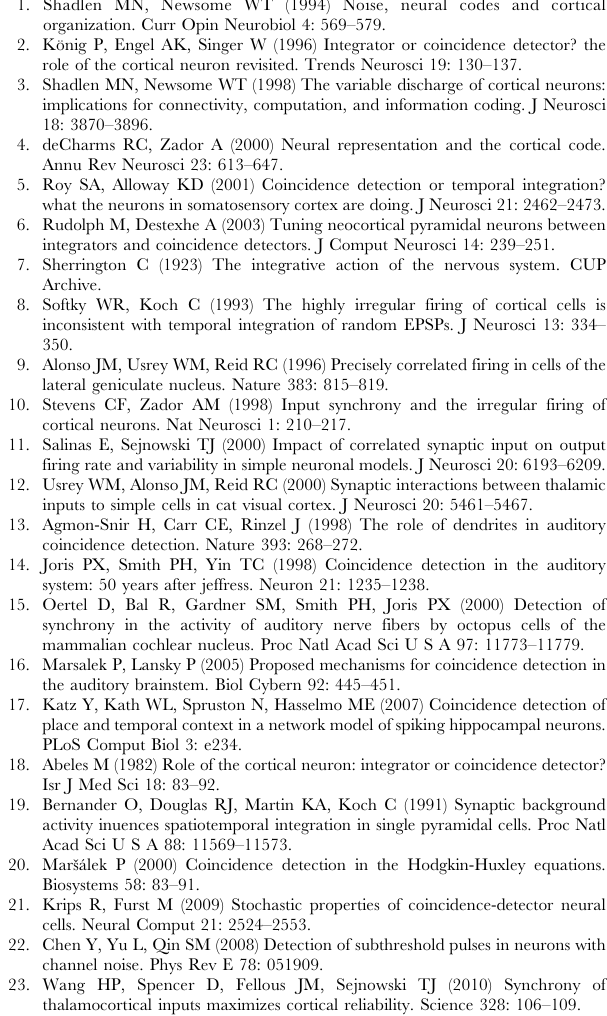
, and it can reach approximately 0 for appropriate pairing of T w and h . (B, C) M